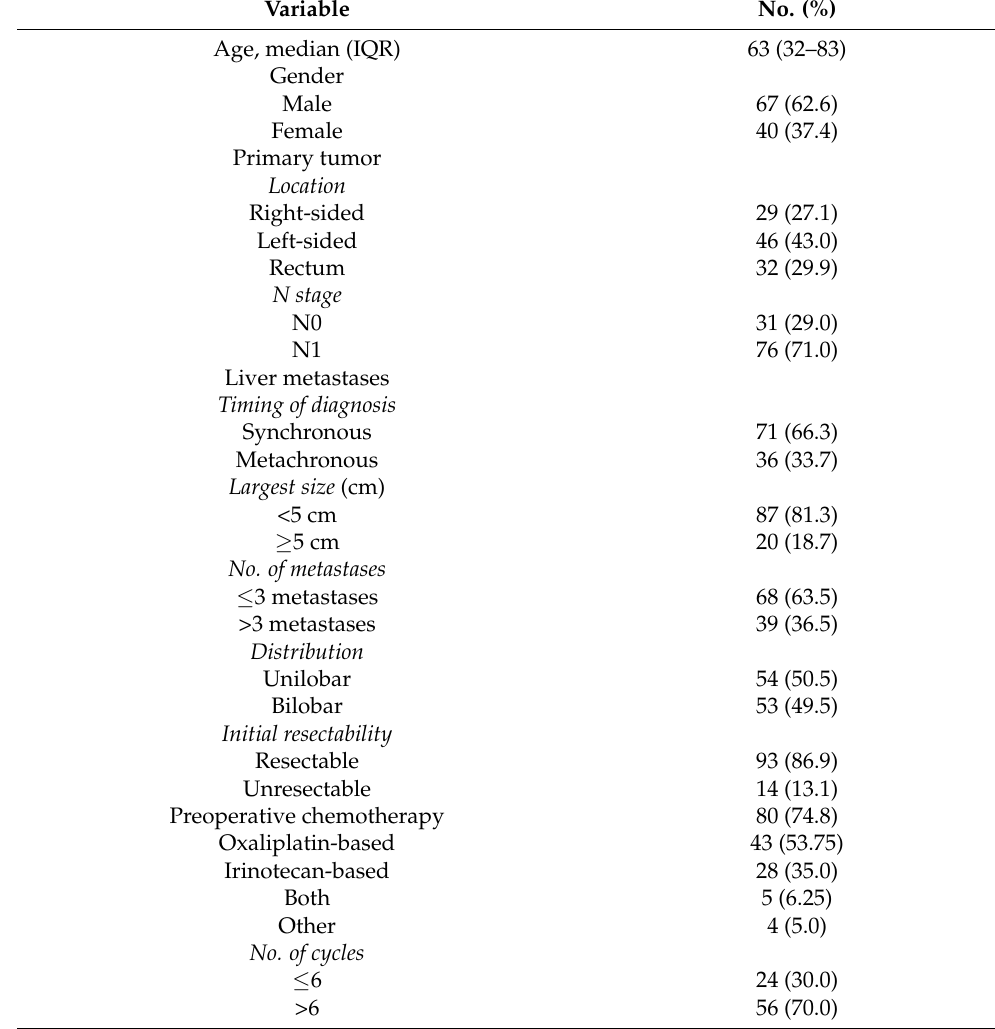
Table 1. Characteristics of the 107 patients with KRAS mutation analysis of the primary tumor and the corresponding